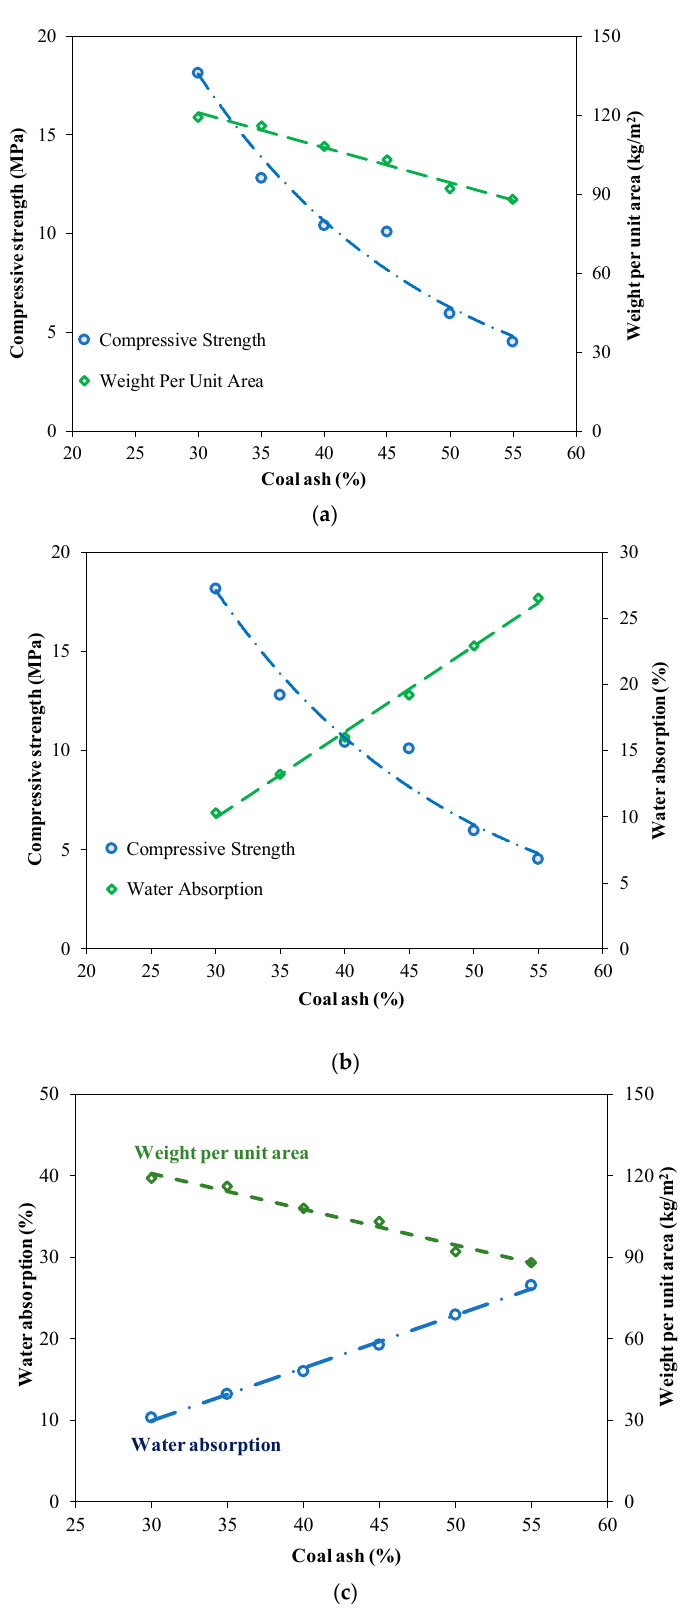
Figure 18. Relationship between the mechanical properties and the durability of bricks. ( a ) Relationship between compressive strength and weight per unit area, ( b ) Relationship between compressive strength and water absorption, ( c ) Relationship between water absorption and weight per unit area.